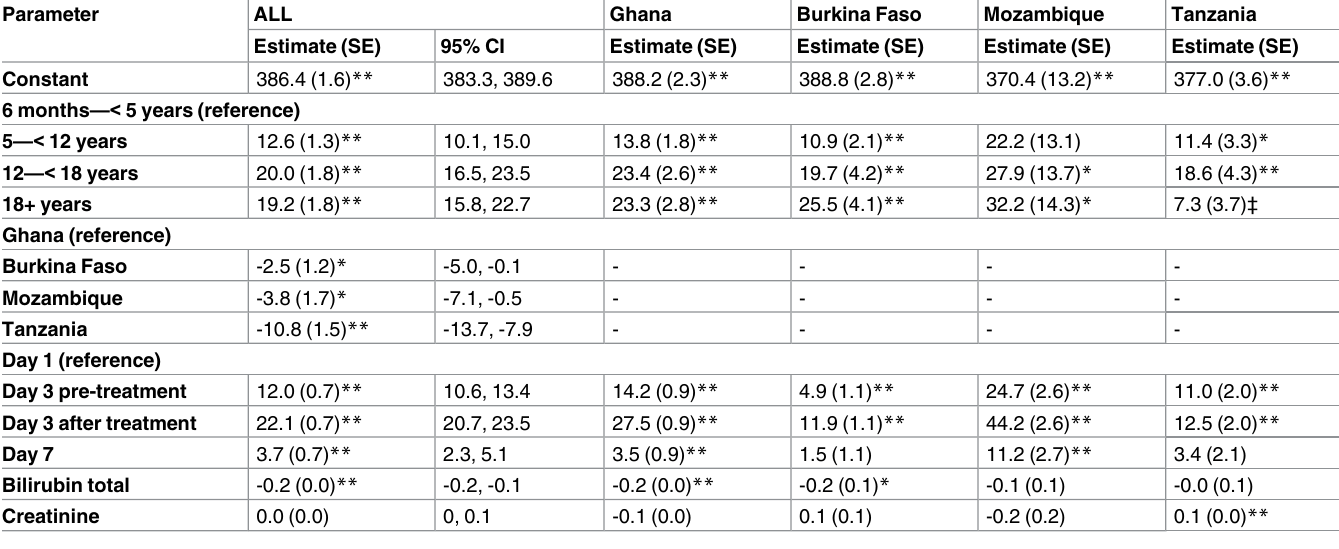
Table 5. Country-wise parameterestimatesfrom linear mixed model.